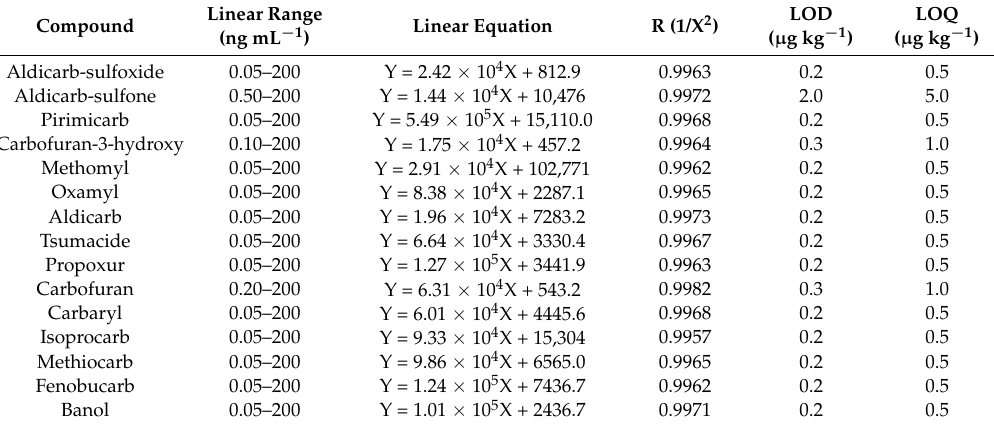
Table 4. Linear ranges, linear equations, correlation coefficients (R) limits of detection (LODs) and limits of quantification (LOQs) of the fifteen carbamate